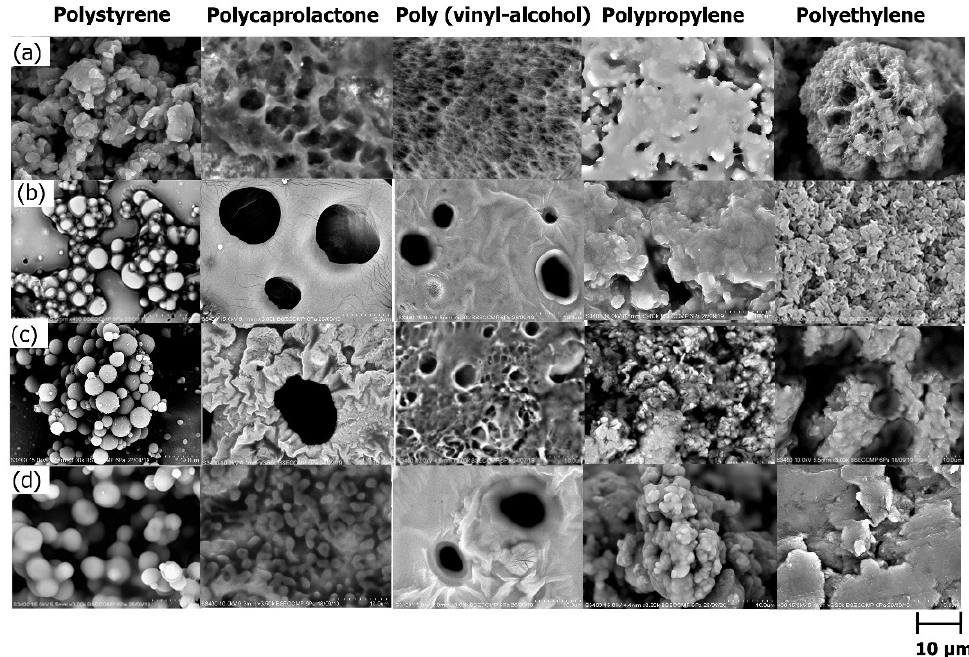
Figure 3. Polymeric templates using different concentrations of surfactant: ( a ) no addition of surfactant, ( b ) 5 wt%), ( c ) 7 wt%, and ( d ) 10